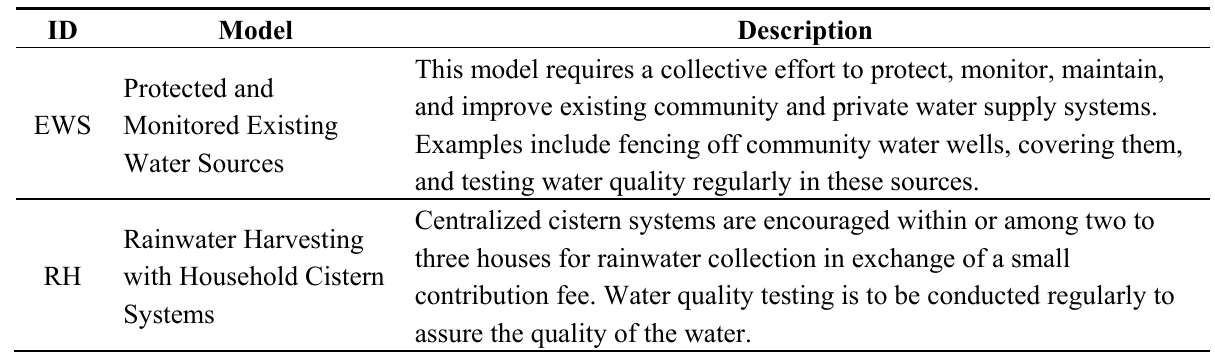
Table 2. Proposed Models for Water Supply Systems for the Yokoè